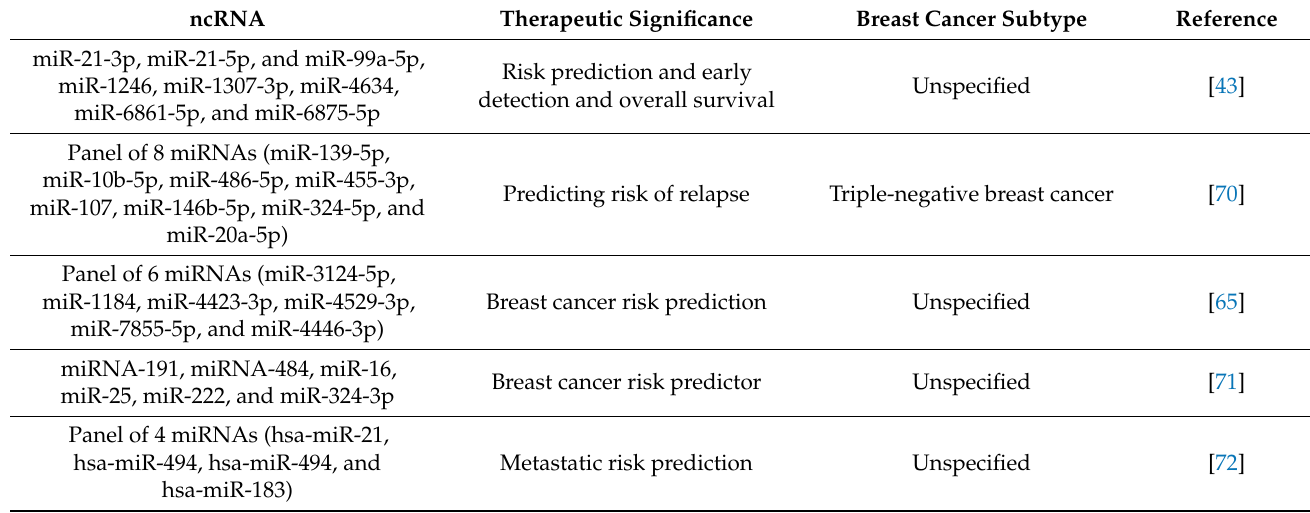
Table 1. A non-exhaustive table of relevant ncRNAs associated with breast cancer risk prediction serving as biomarkers.